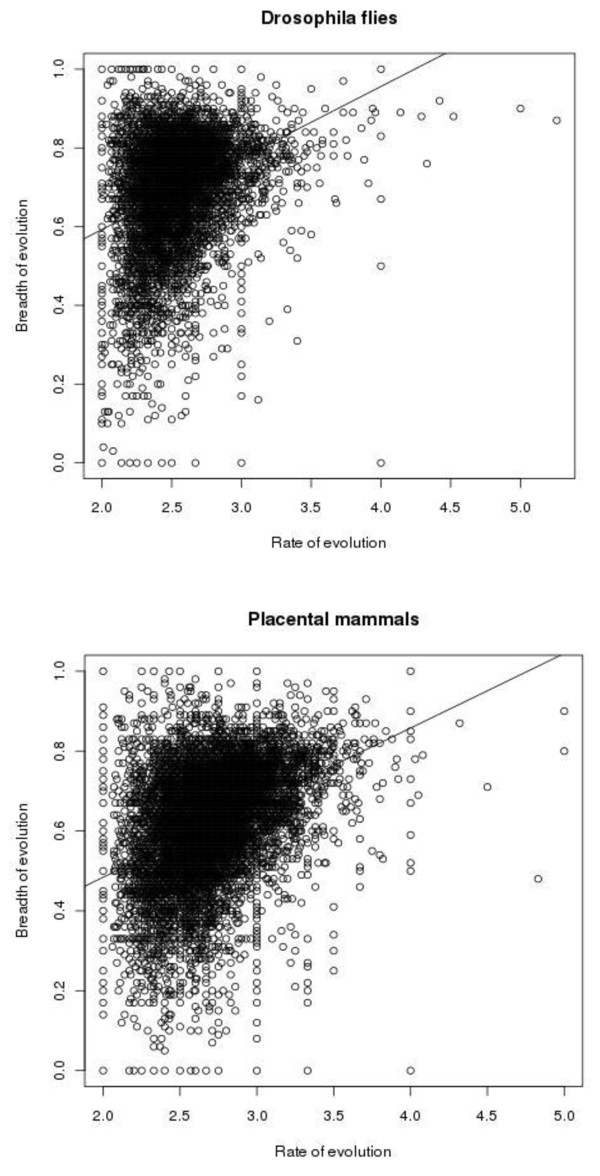
Rates and breadths of evolution of all proteins in Drosophila flies (left) and placental mammals (right).